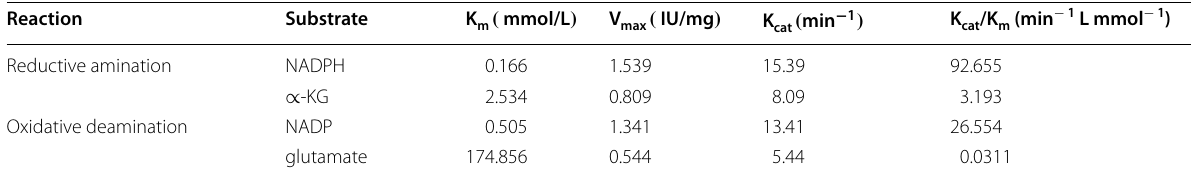
Table 2 Kinetic parameters of GdhA for reductive amination and oxidative deamination reaction Reaction Reductive amination